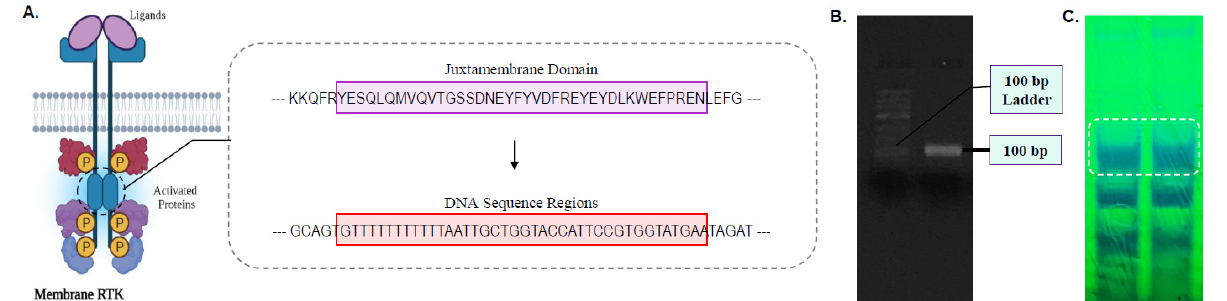
Figure 2. ( A ) The DNA region of the FLT3 gene which corresponds to the juxtamemebrane domain of membrane RTK where ITD occurs. ( B ) Gel-electrophoresis image showing the PCR bands of the FLT3 probe. ( C ) UV shadowing image of PAGE run using the PCR reaction mixture.